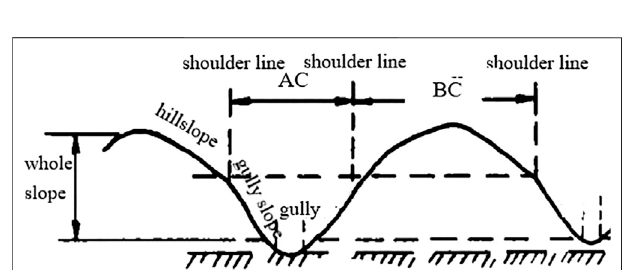
FIGURE 3 | Outline of the loess gullied hilly area.